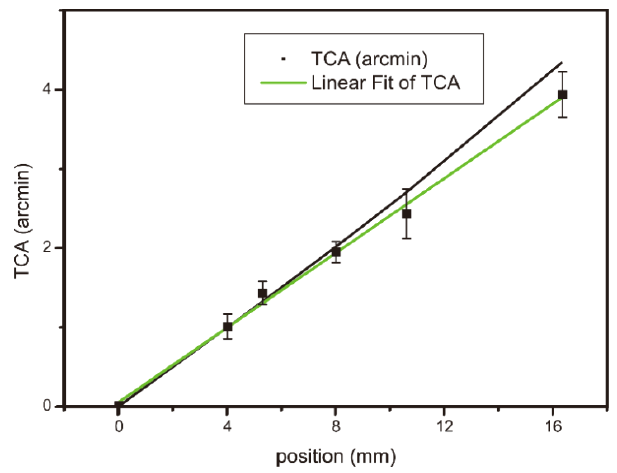
Fig. 5. (Color online) TCA as a function of the position. The black curve represents the calculations, while the green curve represents the ¯tting of the measured values. The black squares represent the mean TCA values for each measurement position, while the error bars represent the standard deviations.